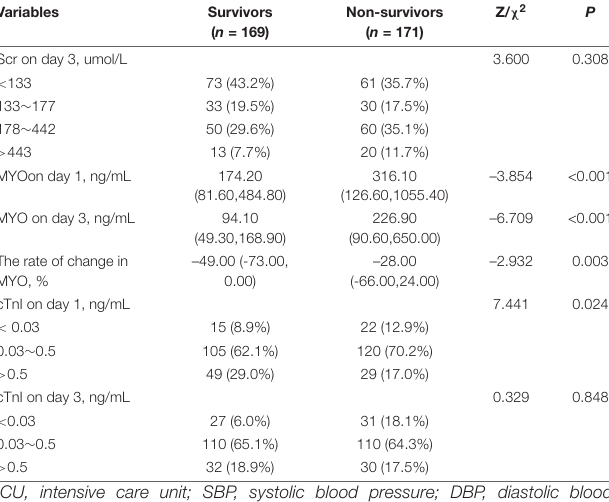
TABLE 1 | Patient clinical